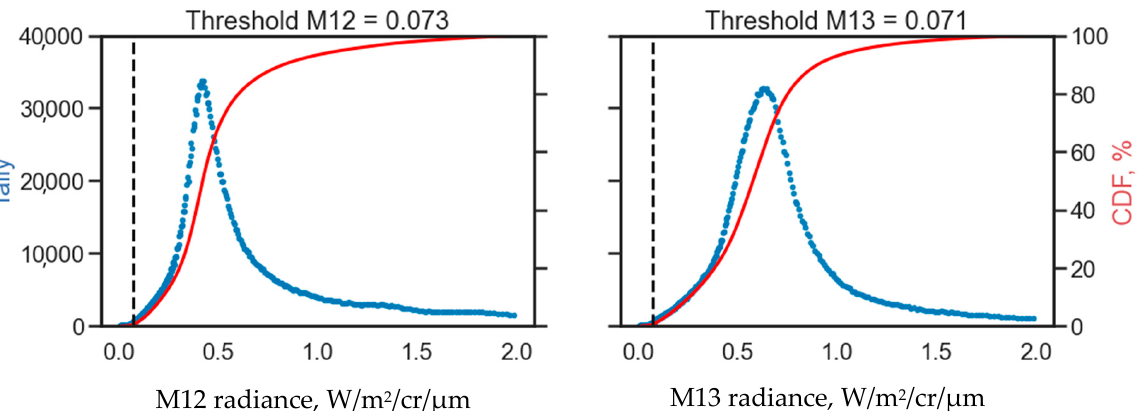
Figure 7. Detection limits for VIIRS bands M12 and M13 are set to the 0.5% point on the CDF generated from the histogram of the radiance values from VNF pixels from entire 2018.